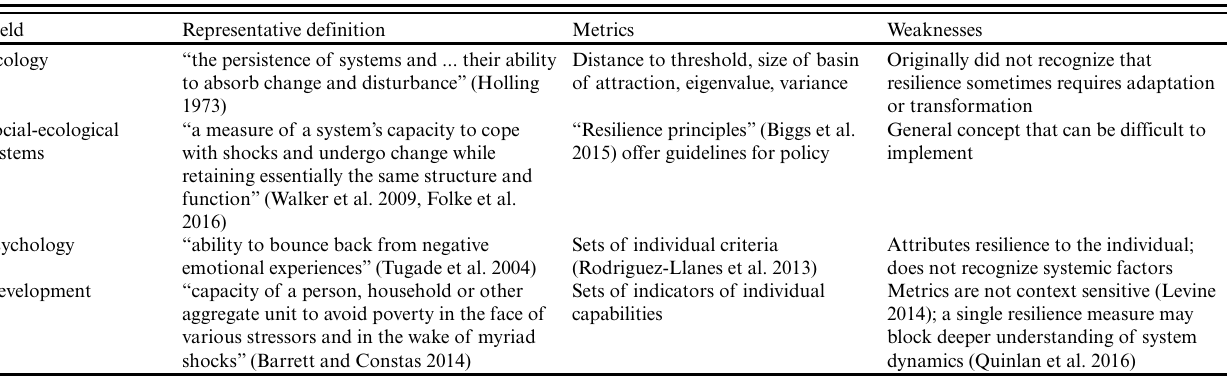
Table 1. Summary of resilience definitions and metrics from various fields. The definitions given are representative only; within each field, there may be strong debate and a large diversity of views on